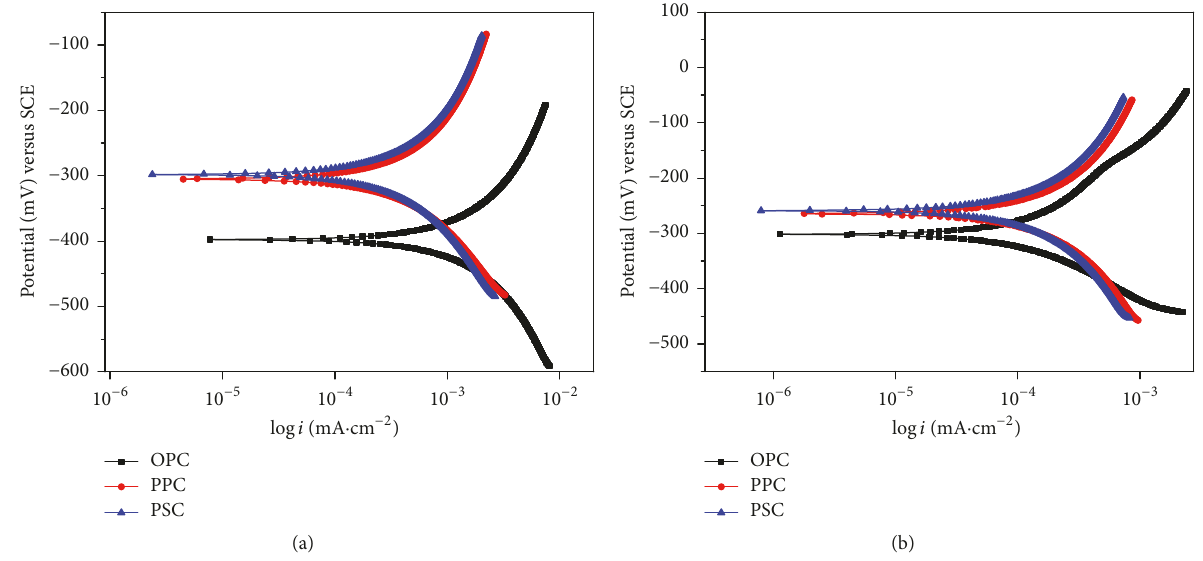
Figure 8: Potentiodynamic polarization curves for TMT rebar embedded in OPC, PPC, and PSC M30 (a) and M40 (b) grade concrete types (90-day cured specimens).